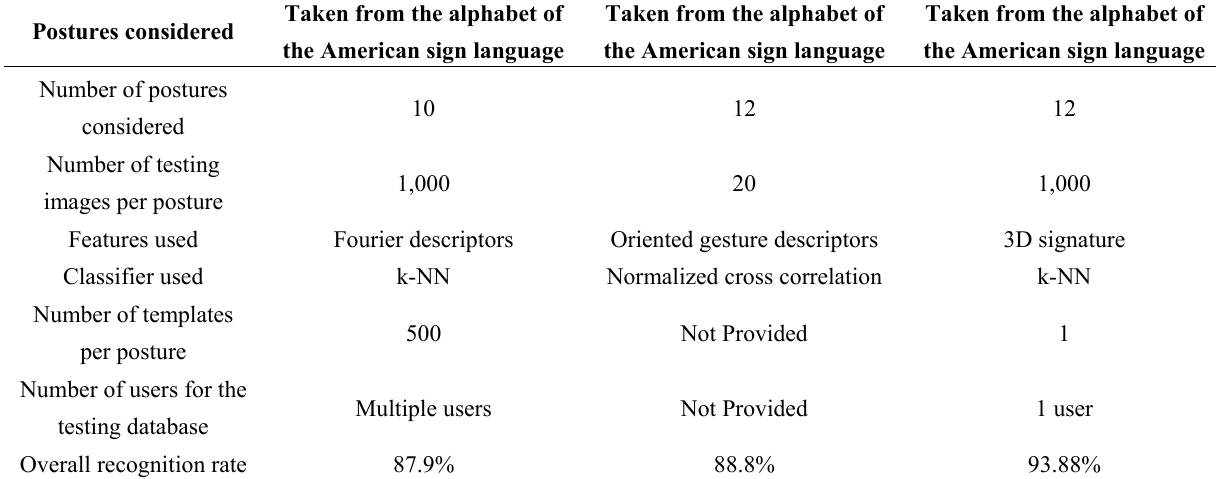
Table 3. Comparison of methods and results between the current study and two